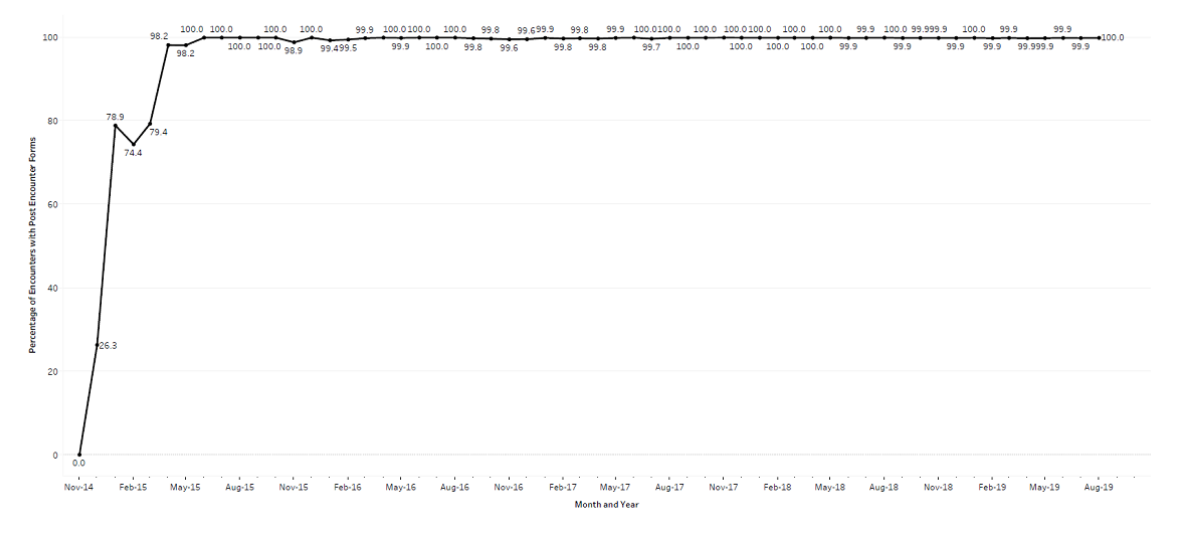
Figure 2. Percentage of Road Home Program encounters with post-encounter forms from November 2014 through September